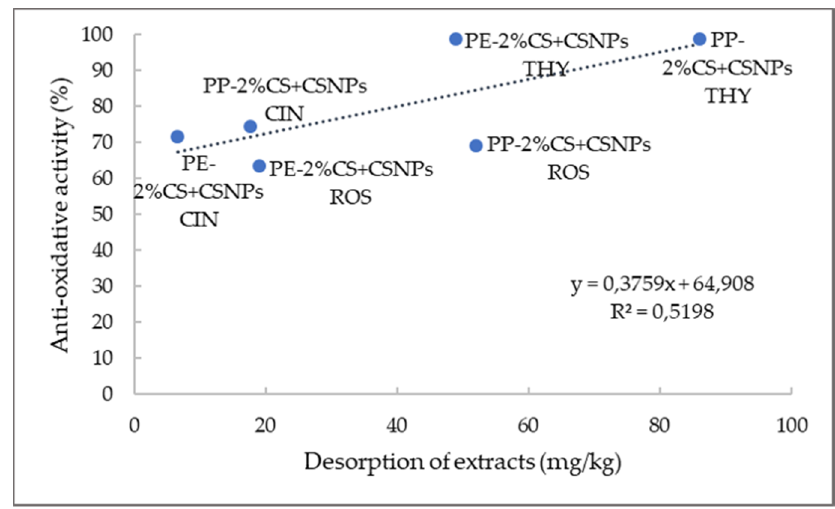
Figure 8. Correlation between amount of released extract and antioxidative activity.